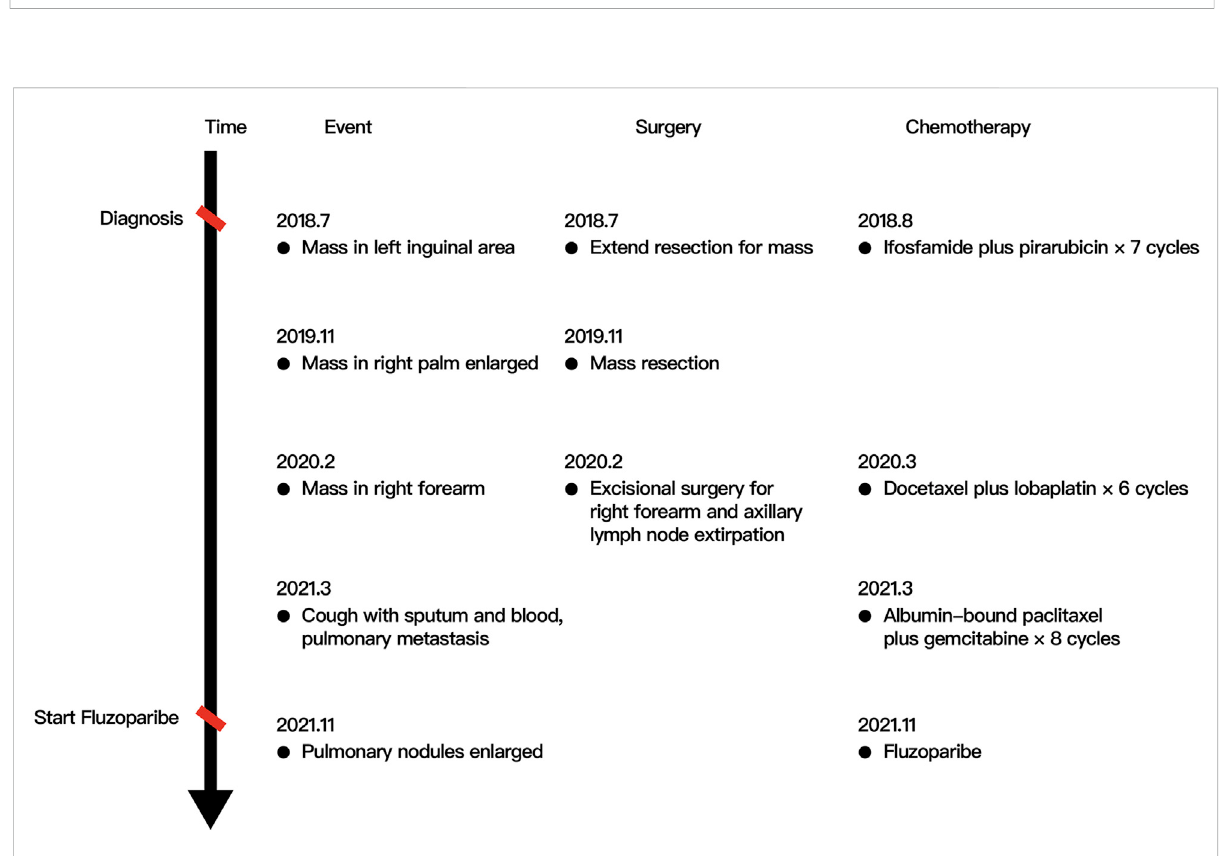
FIGURE 3 Case of a metastatic cutaneous squamous cell carcinoma